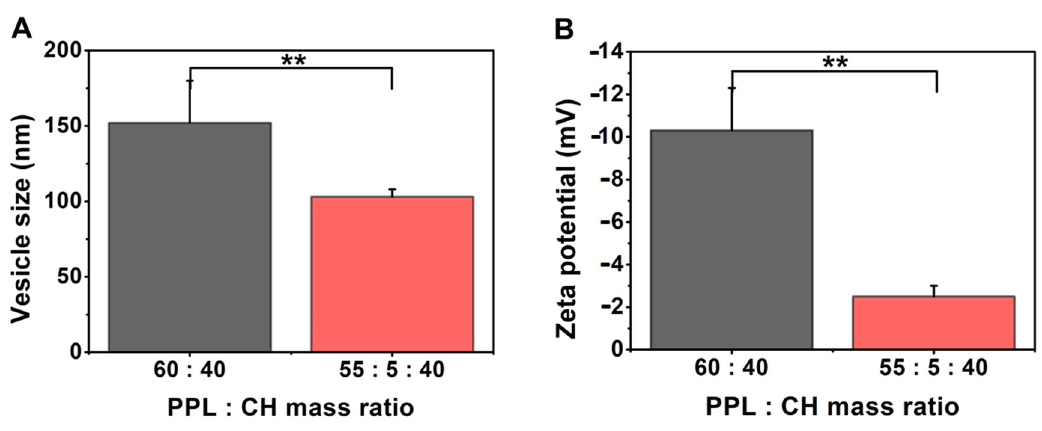
Figure 8. Characteristic features of the liposome samples prepared from phospholipid (PC only or PC and DPPE-PEG 2000 ) and cholesterol (CH) at 60 °C, hydrated with saline solution or PBS pH 7.4 and lyophilised with glucose as cryoprotectant, presenting the results of the investigations: vesicle size and zeta potential analysis ( A , B ). **: p < 0.01. Table 10. Measurement results of the liposome samples prepared from phospholipid (PC only or PC and DPPE-PEG 2000 ) and cholesterol (CH) at 60 °C, hydrated with saline solution or PBS pH 7.4 and lyophilised with glucose as cryoprotectant. Compositions